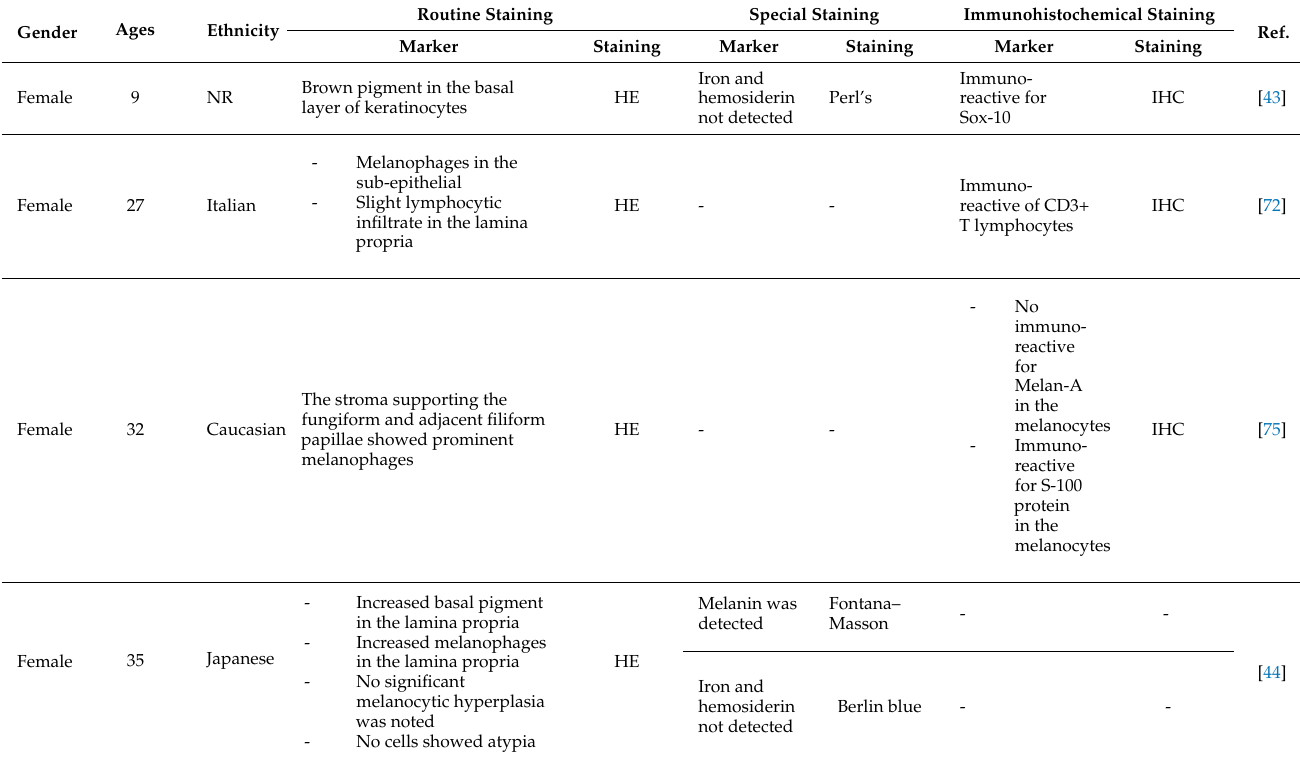
Table 3. Histological findings based on staining of